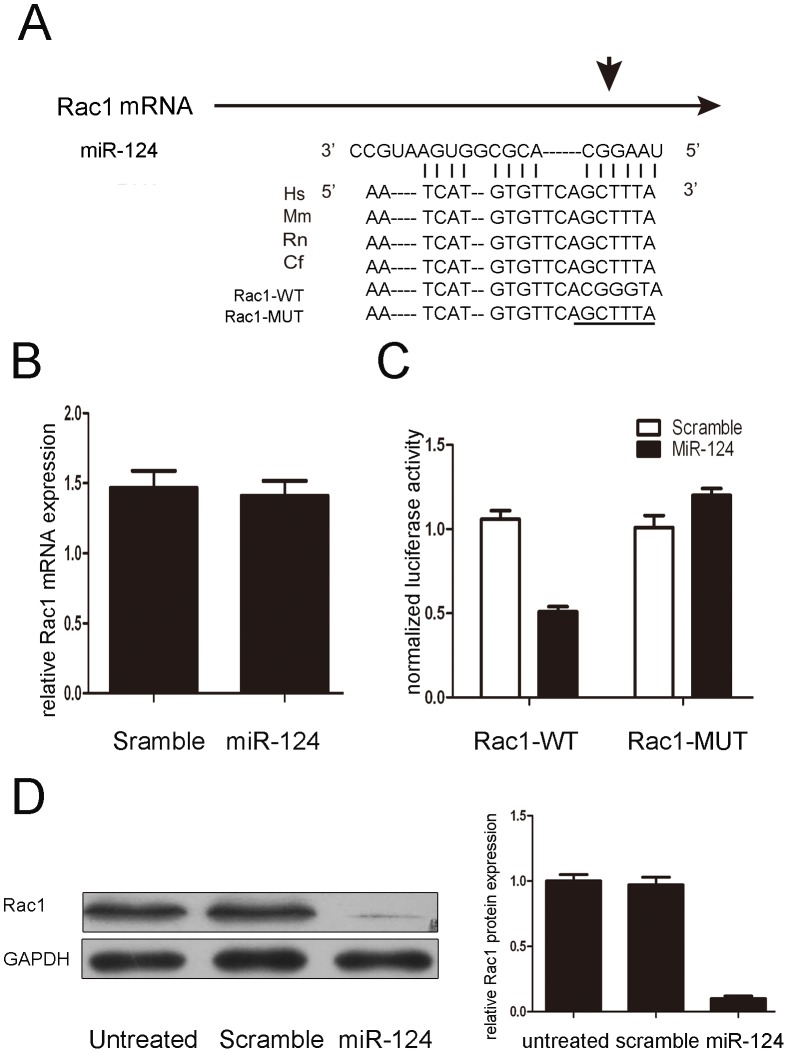
Rac1 is a direct target of miR-124.(A) Predicted duplex formation between human Rac1 3′-UTR and miR-124, Rac1 3′-UTR is highly conserved in different species. Upper panel, sequence alignment of miR-124 with binding site on the Rac1 3′-UTR. Lower panel, sequence of the miR-124 binding site within the Rac1 3′-UTR of four species. (B) MiR-124 cannot alter mRNA level of Rac1 by real-time PCR. (C) Luciferase activity of wild-type (WT-UTR) or mutant (MUT-UTR). (D) Rac1 protein expression in MG-63 cells were transfected with 50 nmol/L of miR-124 mimics , sramble or not transfected.